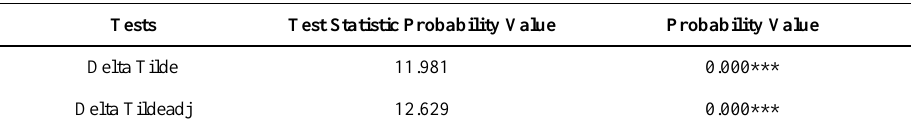
Table 2. Homogeneity Test